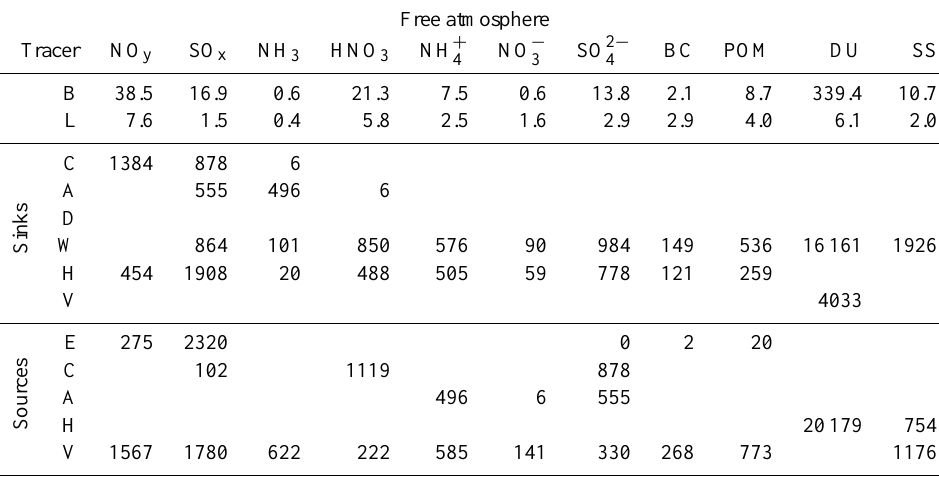
Table 4. European annual budget table of nine tracers for the free atmosphere (850hPa up to top of atmosphere), with (B)urden, (L)ifetime; the sinks: (C)hemical reactions, (A)erosol condensation, (D)ry deposition, (W)et deposition, (H)orizontal transport and (V)ertical transport; and the sources: (E)mission, (C)hemical reactions, (A)erosol condensation, (H)orizontal transport and (V)ertical transport. Vertical transport includes stratospheric interchange. A value of 0 in the table means a value below 0.5 (rounded down to 0), while an empty spot means that the process does not take place at all. Burdens (Gg) are averages of monthly samples. Lifetimes (days) are burdens divided by total sinks. Fluxes (Ggyr − 1 ) are annual totals. NO y includes NO, NO 2 , Peroxyacytyl nitrate (PAN), NO 3 , HNO 4 and N 2 O 5 , but no nitric acid or aerosol nitrate. SO x includes SO 2 and H 2 SO 4 , but no aerosol sulphate. Nitrogen compounds are expressed as masses N, sulphur compounds as masses S and sea salt as masses